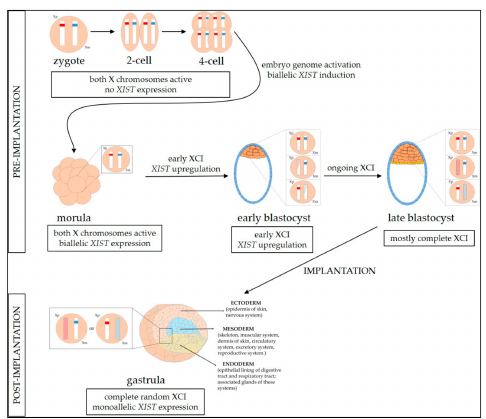
Figure 1. Model of X chromosome inactivation (XCI) in female human early development [14,15]. Female zygote inherits active maternal and paternal X chromosomes (Xm and Xp, respectively). Biallelic XIST expression starts from the four-cell stage concomitant with embryo genome activation and is upregulated in the blastocyst, in which progressive random XCI begins. The embryo at this stage consists of cells with either both X chromosomes active (white) or one X chromosome partially inactivated (red or blue). It is believed that complete XCI stabilizes between early implantation and the end of the first month of the pregnancy with different kinetics depending on cell lineage [16]. The XCI pattern established at the stage of gastrula and its three germ layers is stably maintained and clonally propagated through cell divisions. Nevertheless, the exact timing of complete XCI in humans remains elusive, as investigations past the blastocyst stage remain beyond current